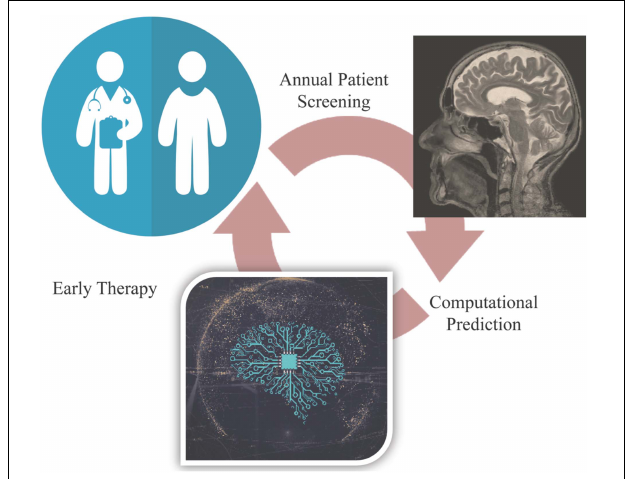
FIGURE 5 | Proposed approach for computer vision-assisted early